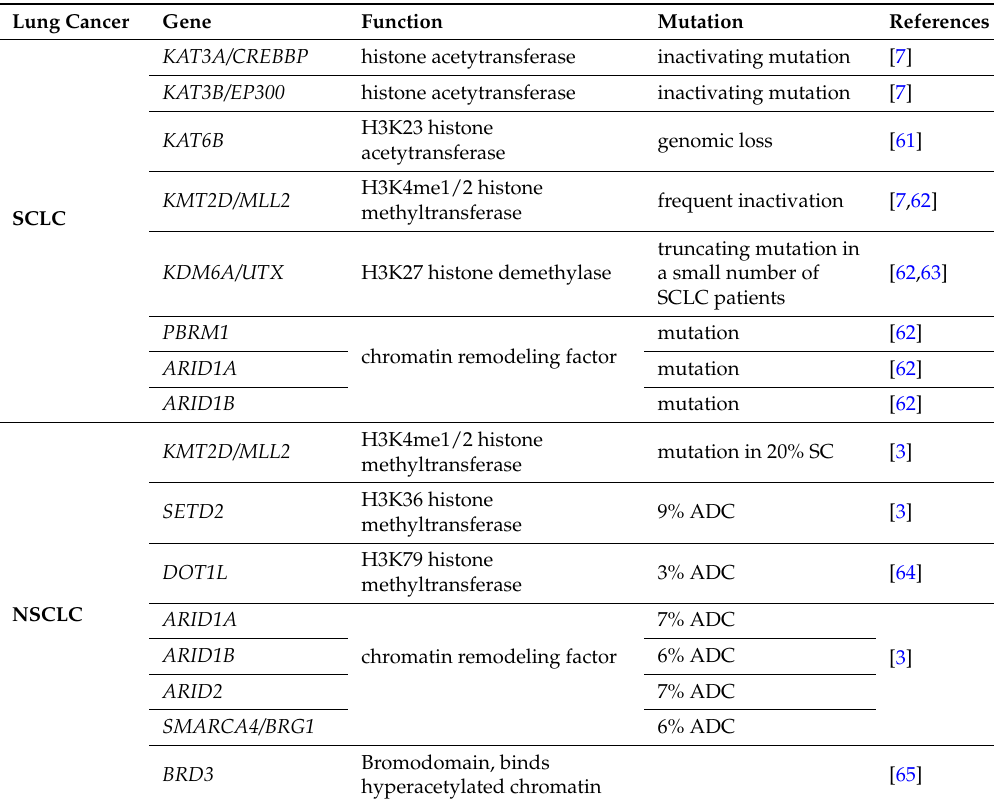
Table 2. Mutations in epigenetic regulators in lung cancers. ADC: Adenocarcinoma; SC: Squamous cell